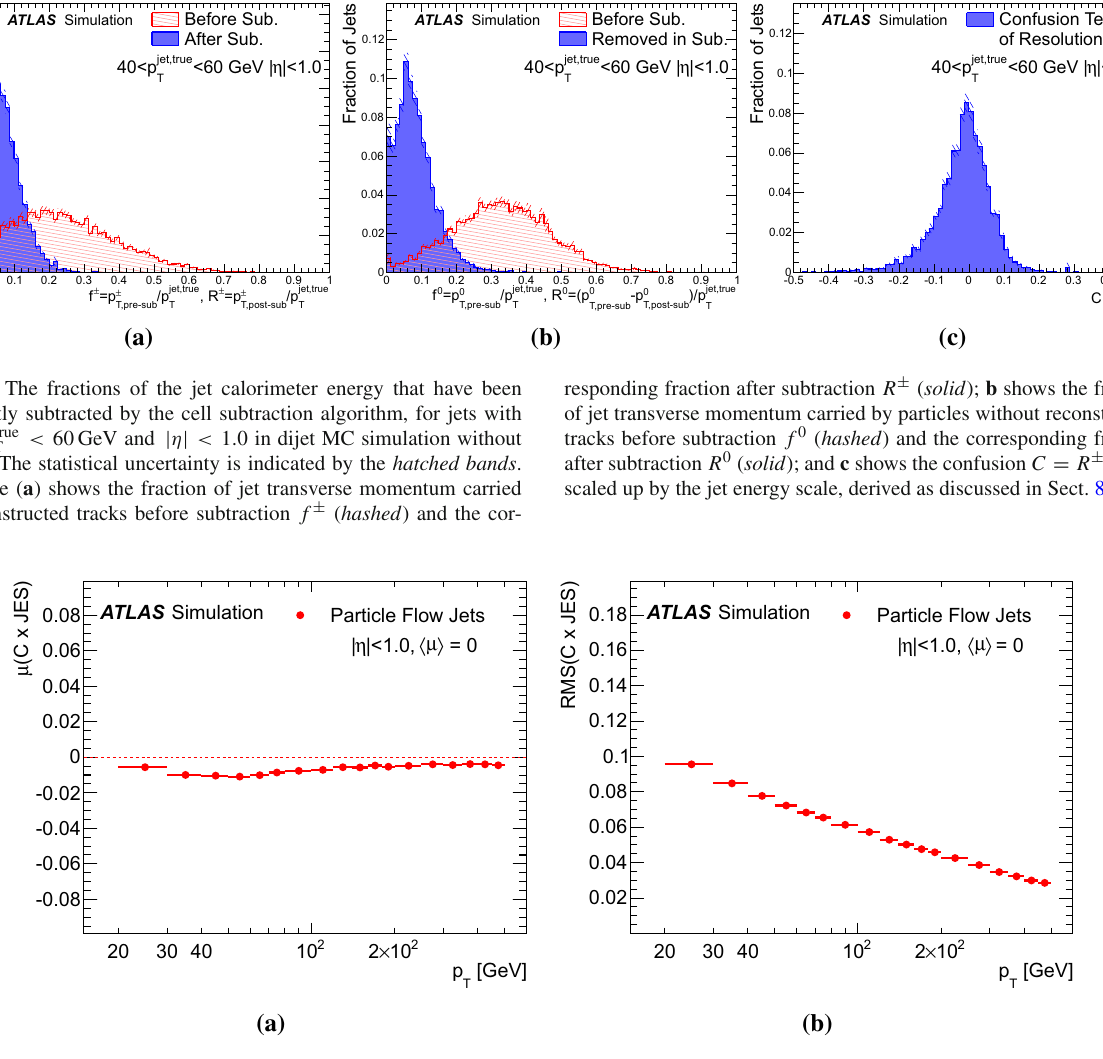
Fig. 21 As a function of the jet p T , subfigure a shows the mean of the confusion term C = R ± − R 0 , scaled up by the jet energy scale, derived as discussed in Sect. 8, and ( b ) shows the RMS of this distribution. The